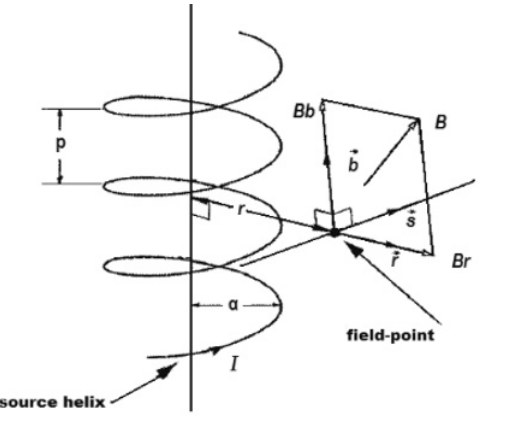
Figure 1. Helical field components generated by a one-wire helix (after